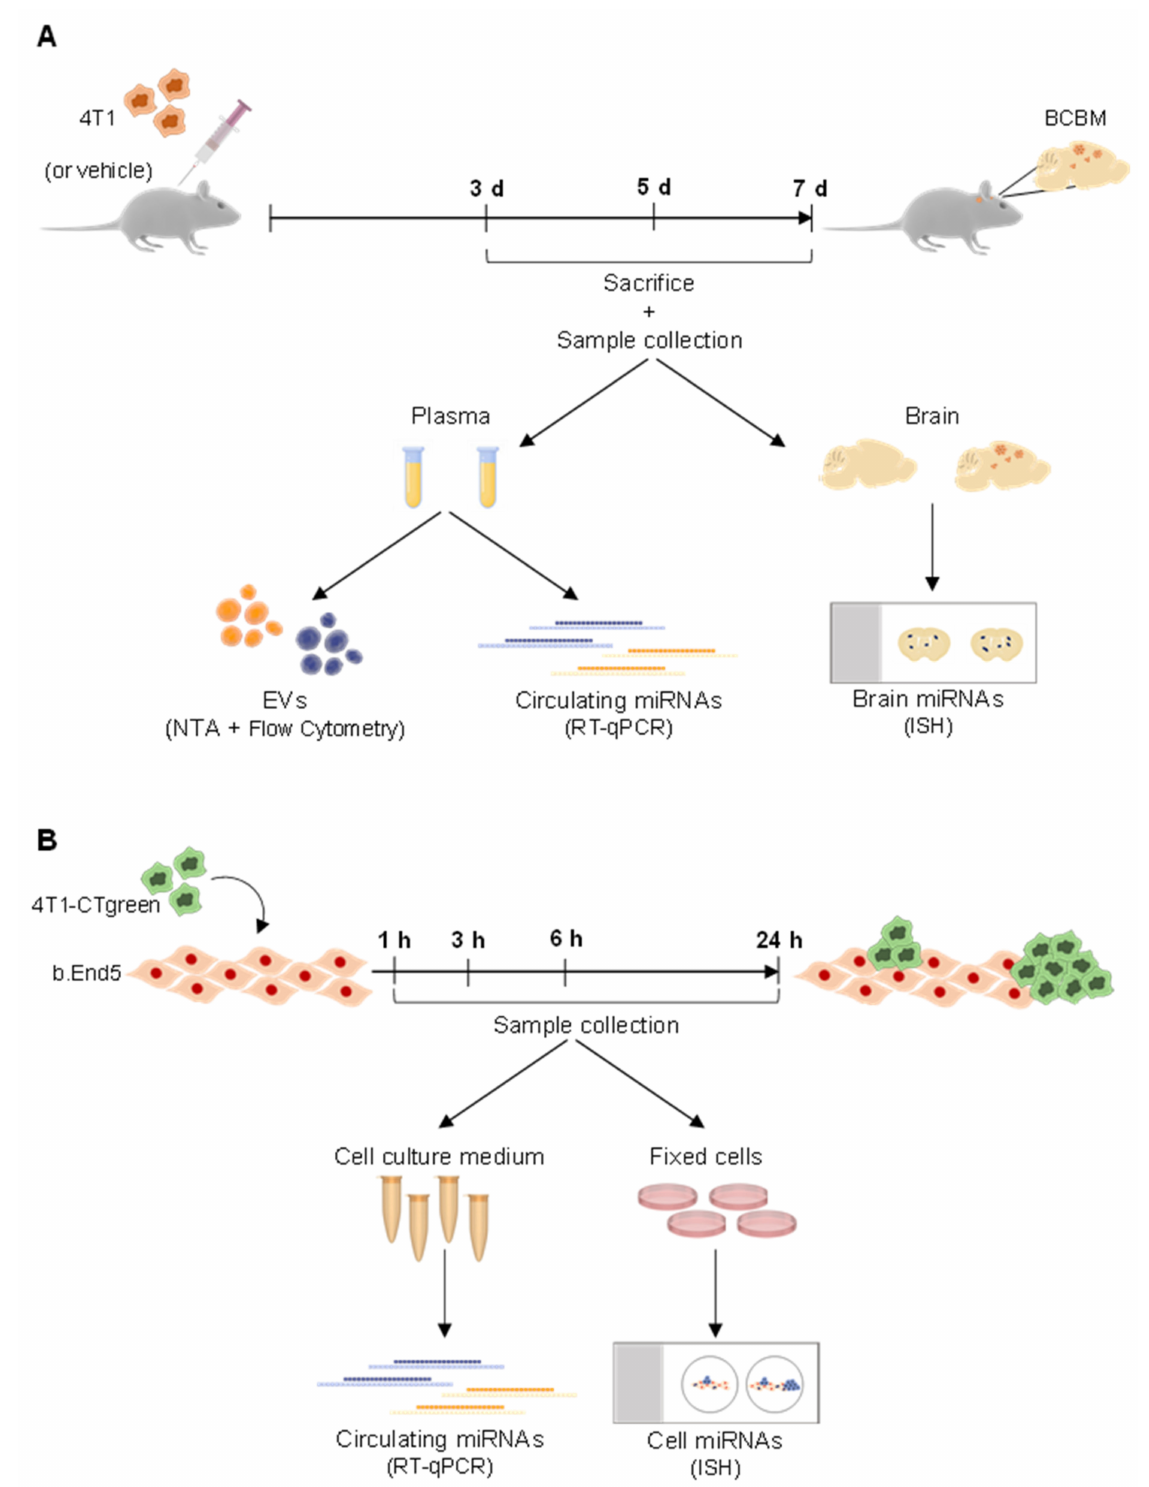
Figure 6. Schematic representation of the experimental design employed regarding in vivo and in vitro studies, as well as sample collection and the following procedures. ( A ) A mouse model of breast cancer brain metastases development was used, relying on the inoculation of murine mammary carcinoma triple negative 4T1 cells, or vehicle (control), into the carotid artery of Balb/c mice. Plasma was collected on the day of sacrifice, performed after 3, 5, and 7 days (d) post-inoculation. Plasma samples were used for quantification of extracellular vesicles (EVs) by Nanoparticle Tracking Analysis (NTA) and by flow cytometry, as well as for early (i.e., 3 days) evaluation of circulating miRNAs by real time quantitative PCR